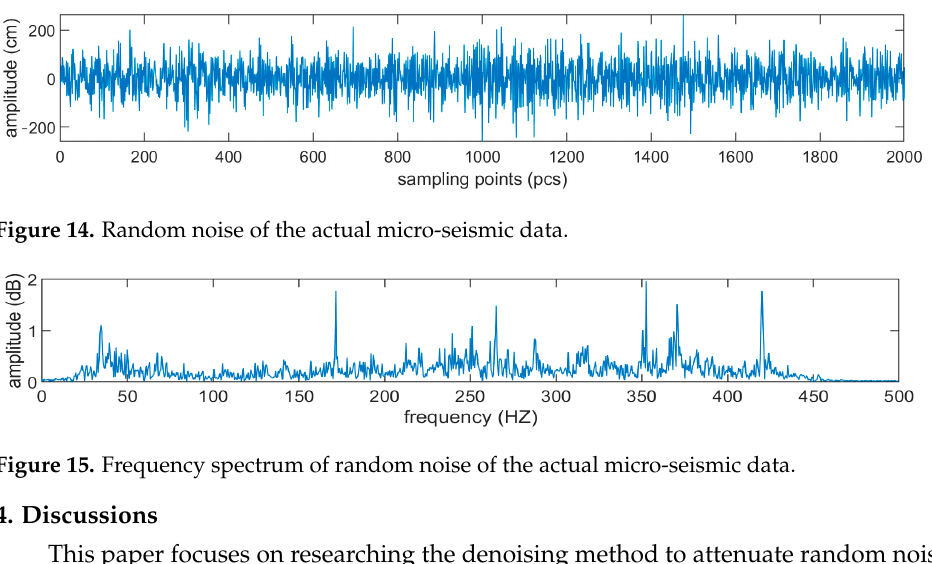
Figure 13. Frequency spectrum of the actual micro-seismic data before and after denoising. ( a ) Over- all frequency spectrum. ( b ) Part of the frequency spectrum.